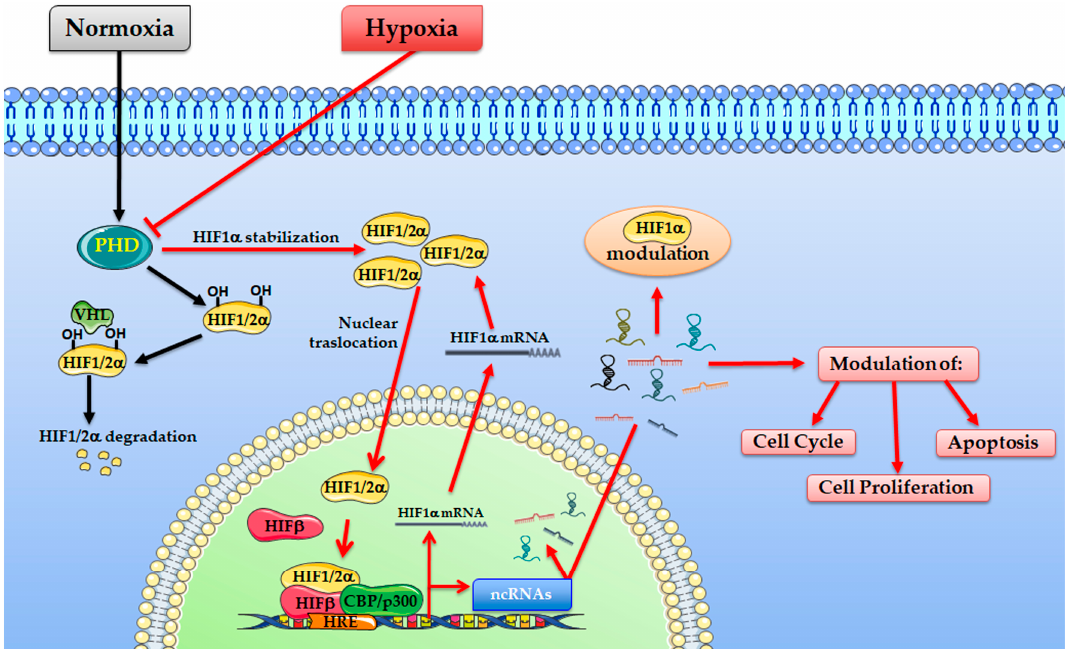
Figure 1. Hypoxia-inducible factor (HIF) complex transcriptionally activates non-coding RNAs (ncRNAs) in response to hypoxia. Under normoxia (black arrows), HIF-1/2 α subunits are subjected to hydroxylation by prolyl hydroxylase domain enzymes (PHDs) and other prolyl hydroxylases. Hydroxylated HIF-1/2 α subunits are recognized by VHL proteins and targeted for subsequent ubiquitination and proteasomal degradation. Under hypoxia (red arrows), low pO 2 results in HIF-1/2 α accumulation, nuclear translocation and dimerization with HIF-b, finally, after recruitment of CBP/p300, the transcription initiation complex binds the promoter of target genes inducing their expression. Among the hypoxia-induced RNAs, the ncRNAs (miRNAs or lncRNAs) will be involved in different pathways, regulating cell proliferation, cell cycle and cell death. Moreover, some of these can regulate HIF itself.